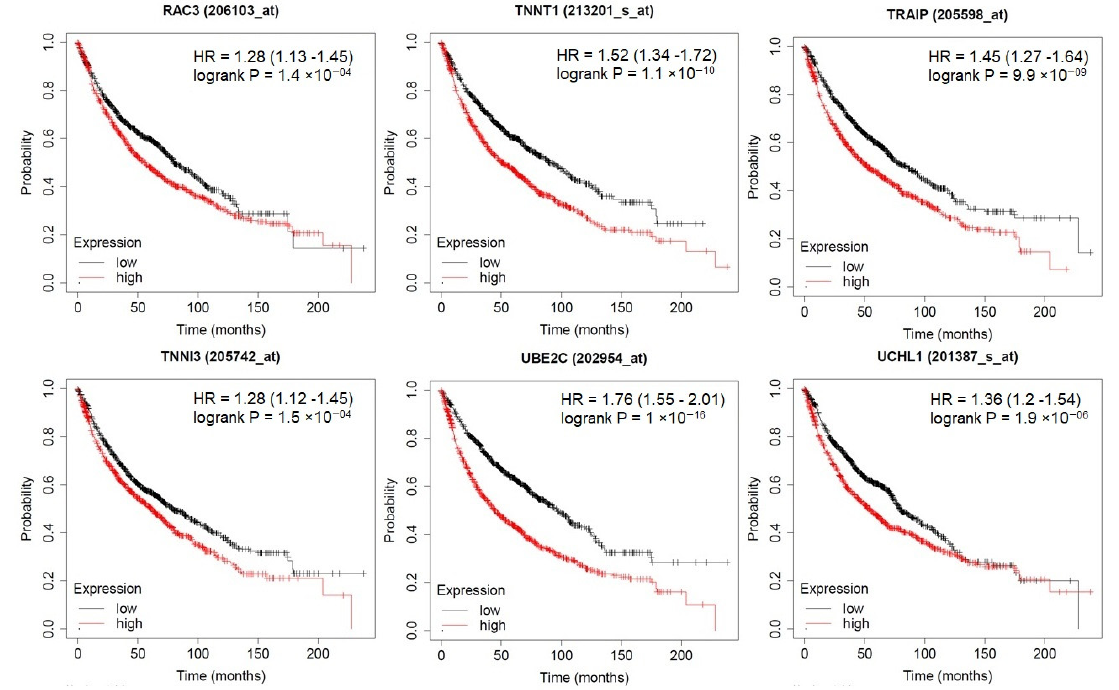
Figure 8. The prognostic value of PTGs in LUAD patients. High expression of UBE2C, UCHL1, TRAIP, TNNT1, TNNI3, and RAC3 was associated with poor overall survival of LUAD patients ( p < 0.05).